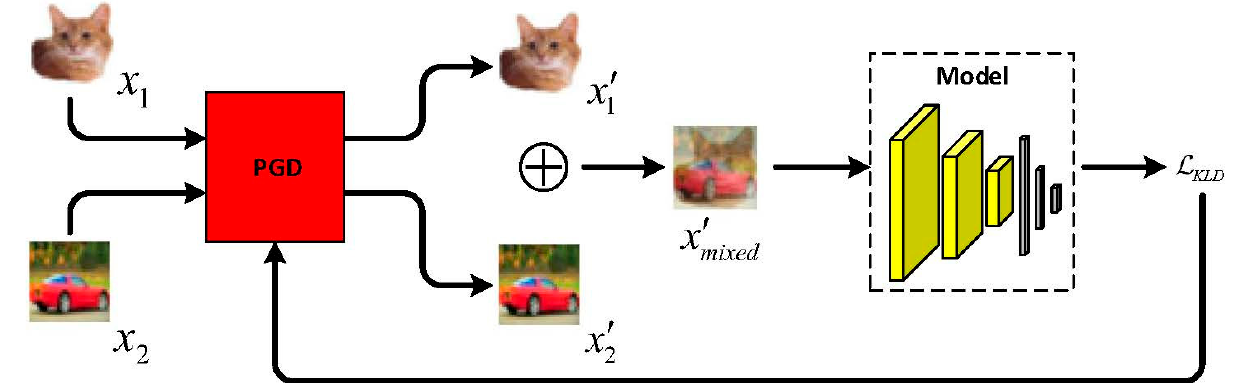
Figure 4. The training procedure of BCAT (+). In each training step, (1) the threat model attacks the model using PGD to generate adversarial examples; (2) the adversarial examples having different true labels are mixed two by two; (3) the mixed adversarial examples are used to train the model to output the mixing ratio. This procedure is iterated until the model converges.